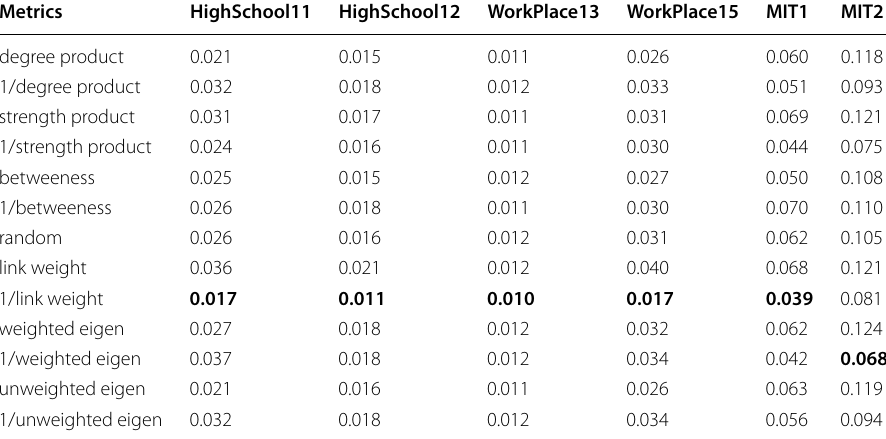
The lowest average prevalence value for each dataset is highlighted in bold